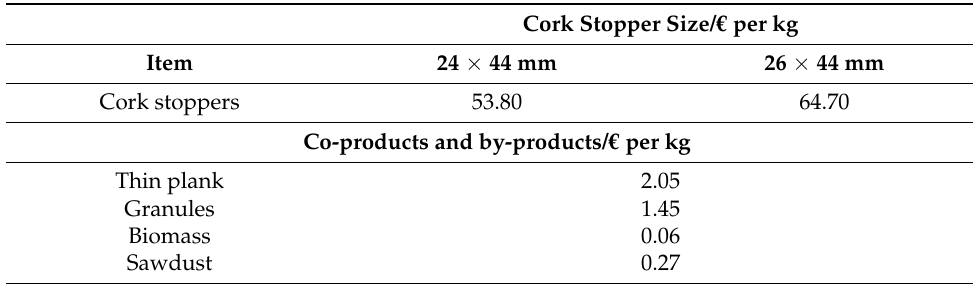
Table 3. Commercial value of natural cork stoppers and